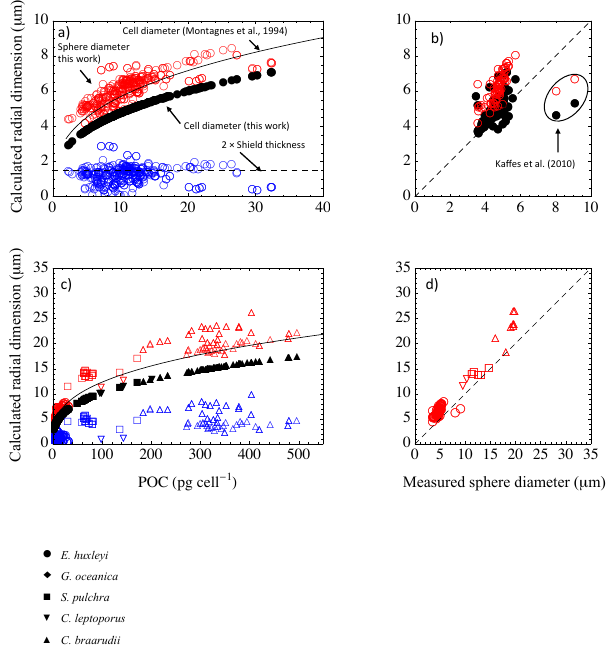
Figure 2. Geometric model used to obtain cell and coccosphere ge- ometry from measurements of the particulate organic carbon (POC) and particulate inorganic carbon (PIC) content per cell measured in culture experiments. Panels (a) and (c) show the relationship be- tween POC and PIC and cell geometry (cell and coccosphere diame- ter) calculated with Eq. (7). Panels (b) and (d) show the relationship between the cell and coccosphere diameter calculated with Eq. (7) and that measured in culture experiments. Notes: panels (a) and (b) present data for E. huxleyi , and panels (c) and (d) present data from the other coccolithophore species in the database. The filled black dots are the cell diameter, the empty red symbols are the coc- cosphere diameter and the empty blue symbols are the difference between the coccosphere and cell